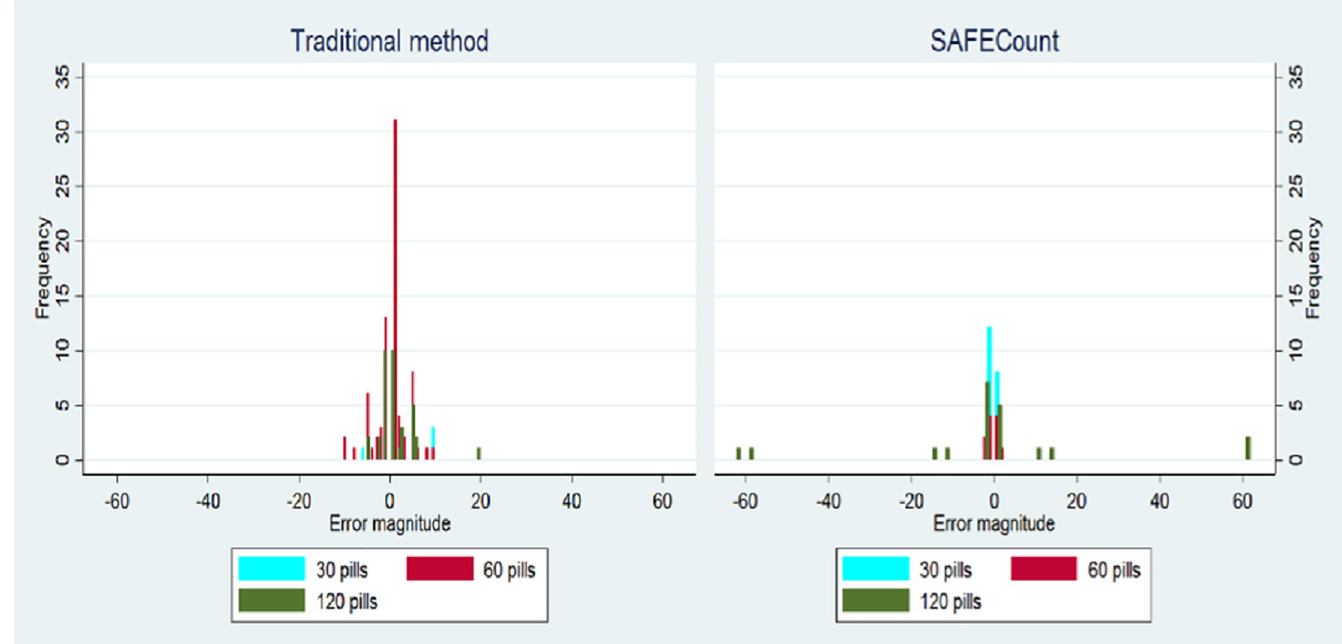
Fig 3. Distribution of magnitude of prescription errors.